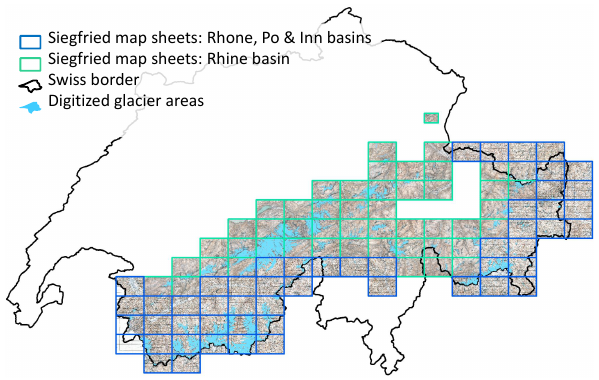
Figure 1. The 80 sheets of the Siegfried map covering the glacier- ized area of the Swiss